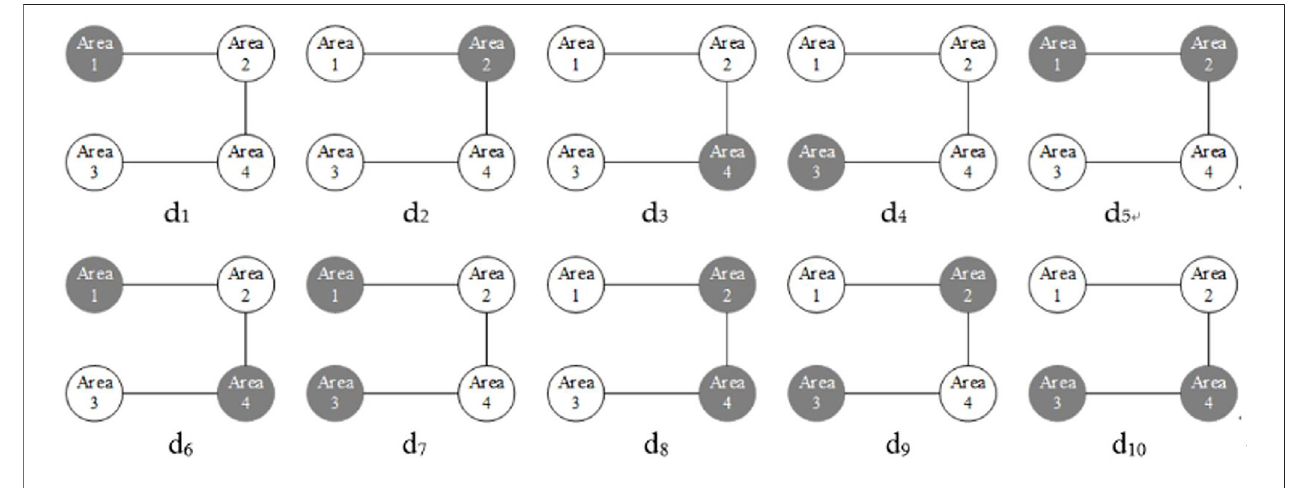
FIGURE 9 | Different deployment methods.